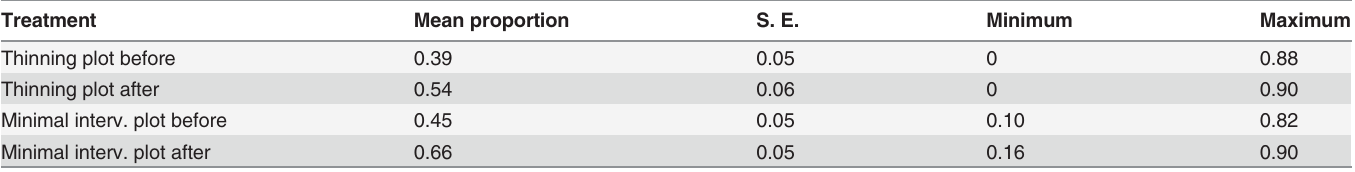
Table 4. Descriptive statistics for the proportion of juveniles, summed over all species (with sufficient sample size), for n = 19 sites with sufficient number of specimens to calculate the proportions. Treatment